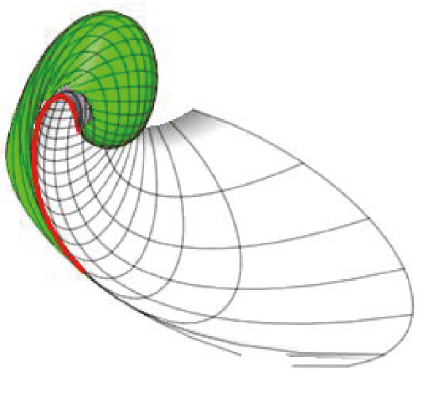
Figure 7: Projection of IS 𝛾 ± (𝑠,𝜇) (in green and in gray) and C 𝛾 (𝑠) (in red) on 𝑥 1 𝑥 2 𝑥 3 -space.